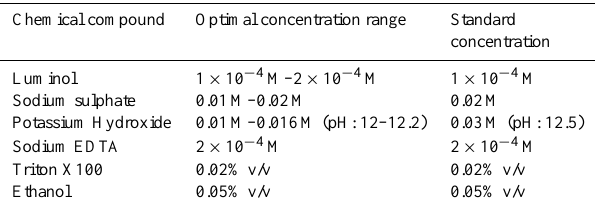
Table 1. Chemical compounds and concentrations used in the aque- ous solution of luminol. The second column shows the optimal con- centration range for the chemical compounds. The concentrations (M=mol/l) that are applied in this paper are shown in the third col- umn. The standard solutions have a higher than optimal concentra- tion for potassium hydroxide, which is chosen to compensate for the effect of acidification by carbon dioxide. See Sect. 3 for more details.